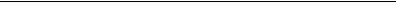
Figure 5 . Distribution of novelty scores in the O 0 samples corresponding to the same BPs as in figure